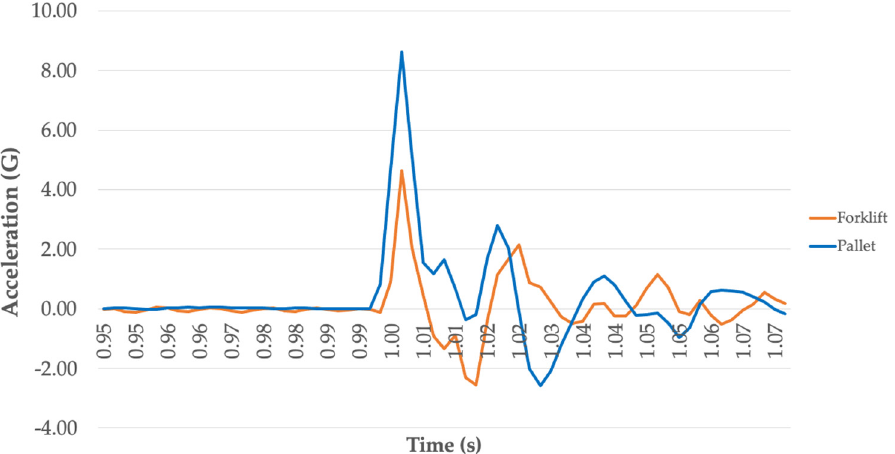
Figure 8. Representative picture of a shock response curve for events measured in the forklift and the pallet.